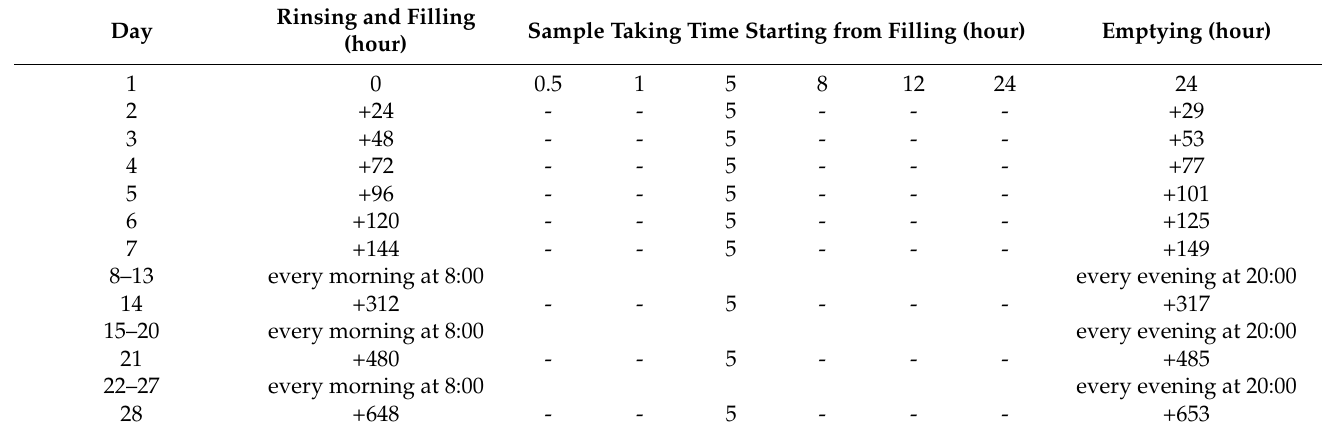
Table 2. Study project and water bottle sampling plan (n = 20 double water